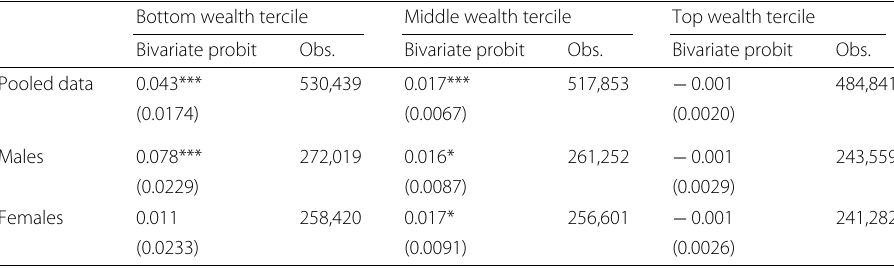
Table 3 By wealth terciles: effects of remittances on secondary school enrollment Bottom wealth tercile Middle wealth tercile Top wealth tercile Bivariate probit Obs. Bivariate probit Obs. Bivariate probit Obs. Pooled data 0.043*** 530,439 0.017*** 517,853 − 0.001 484,841 (0.0174) (0.0067) (0.0020) Males 0.078*** 272,019 0.016* 261,252 − 0.001 243,559 (0.0229) (0.0087) (0.0029) Females 0.011 258,420 0.017* 256,601 − 0.001 241,282